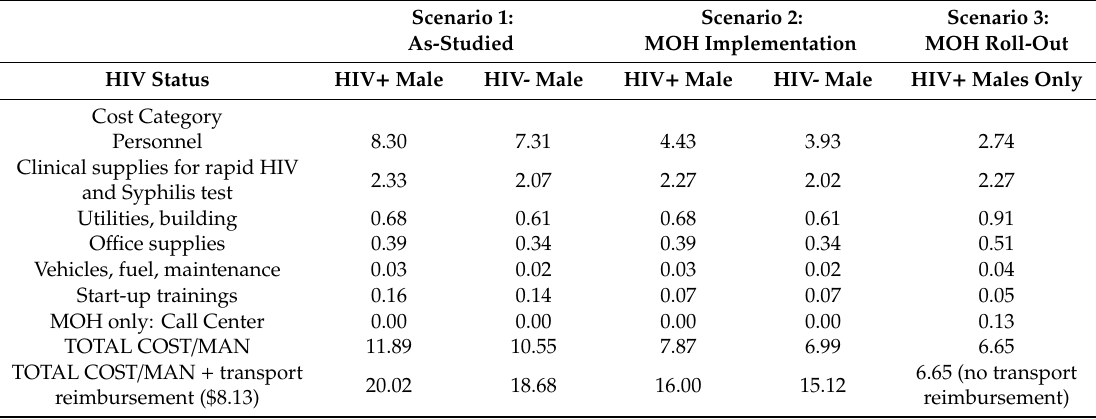
Table 2. Average costs per male tested for HIV in a clinic, as a result of secondary distribution of HIVST kits, per each scenario (2019